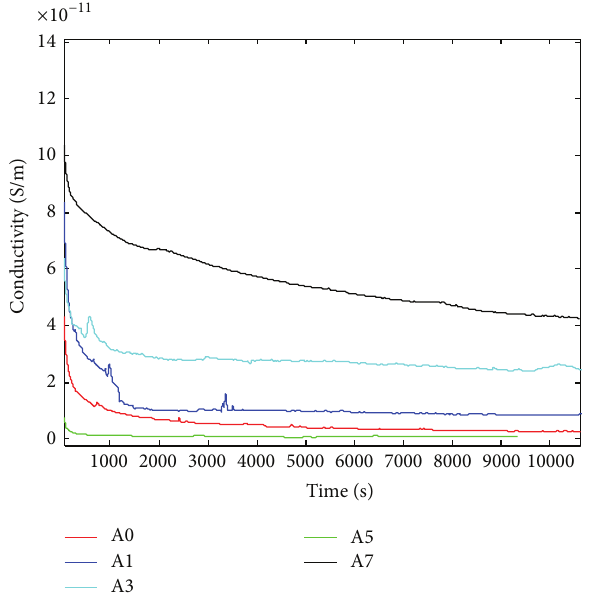
Figure 9: Conductivity variations for sample LLDPE-NR/SiO 2 at different amount of